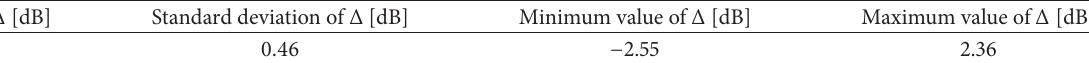
Table 6: Results of the Monte Carlo simulations for V ̸= 1 and 𝑙 ̸= 1 .